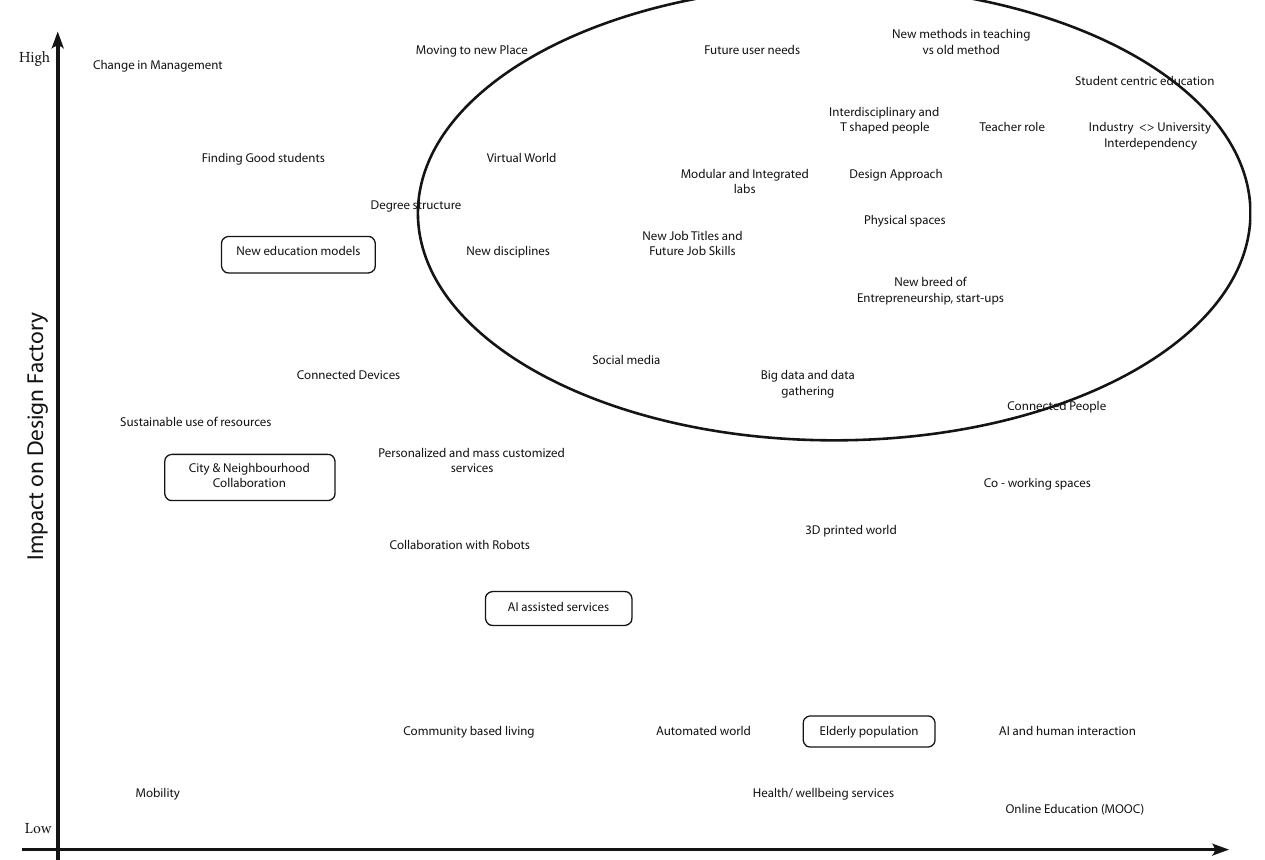
Fig. 3 Graph-based sorting of